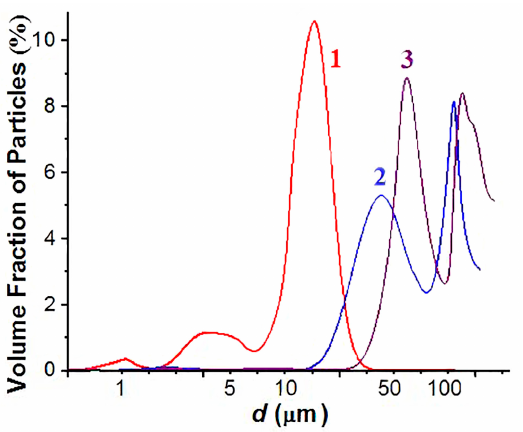
Figure 6. Differential particle-size distribution curves of samples of (1) Mt, (2) P Rh and (3) P Rh -Mt systems (90:10).